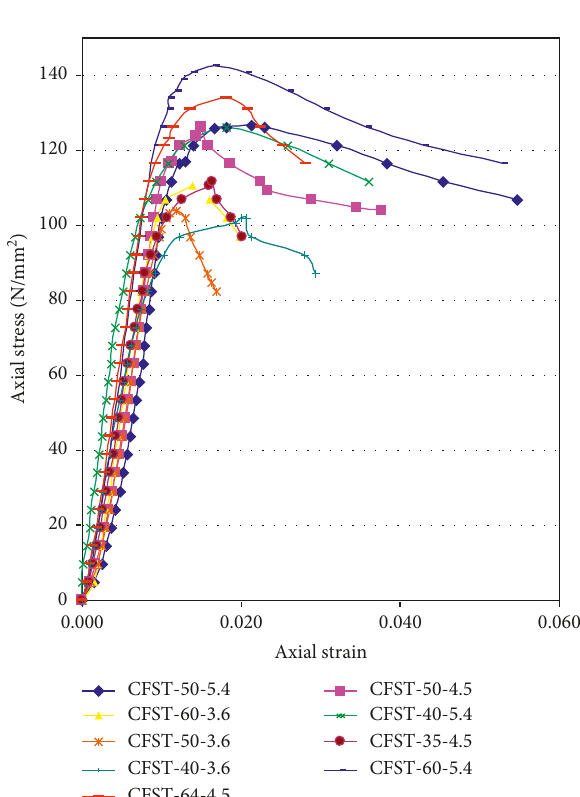
Figure 3: Comparison of the effects of the D/t ratio and concrete strength on axial stress–strain